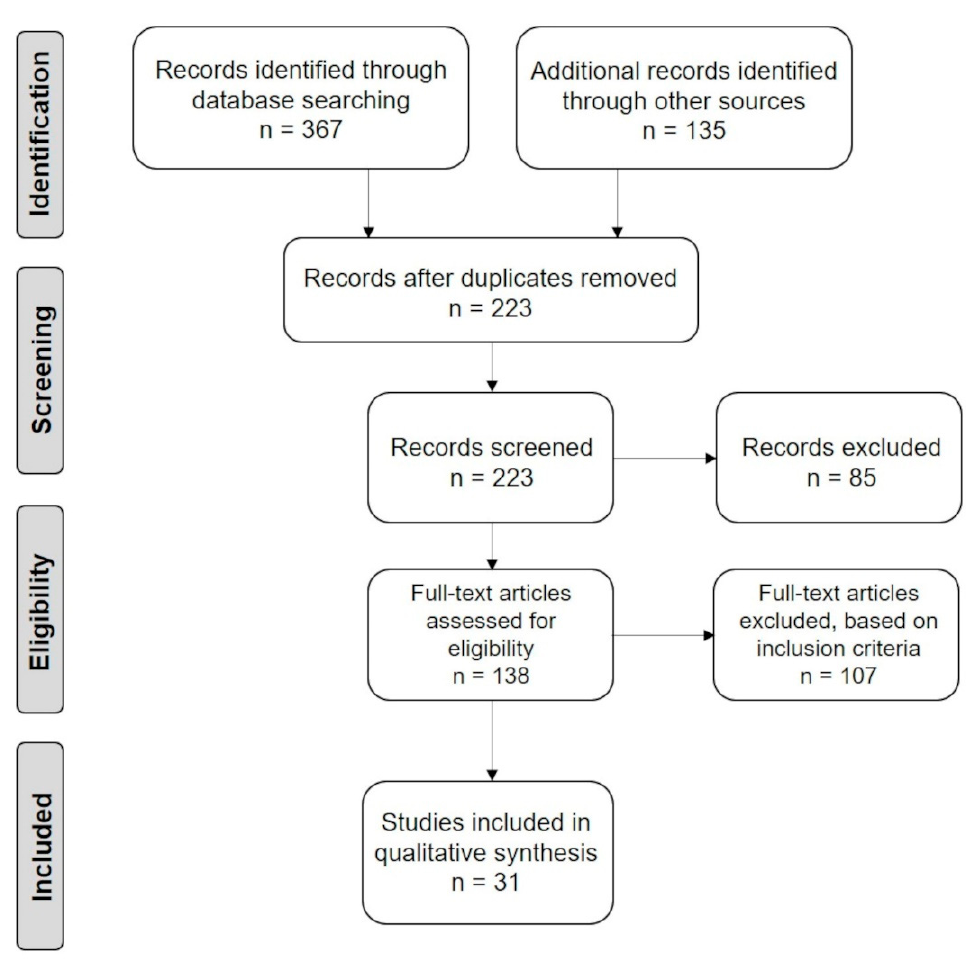
Figure 1. Flow diagram representing the literature search.